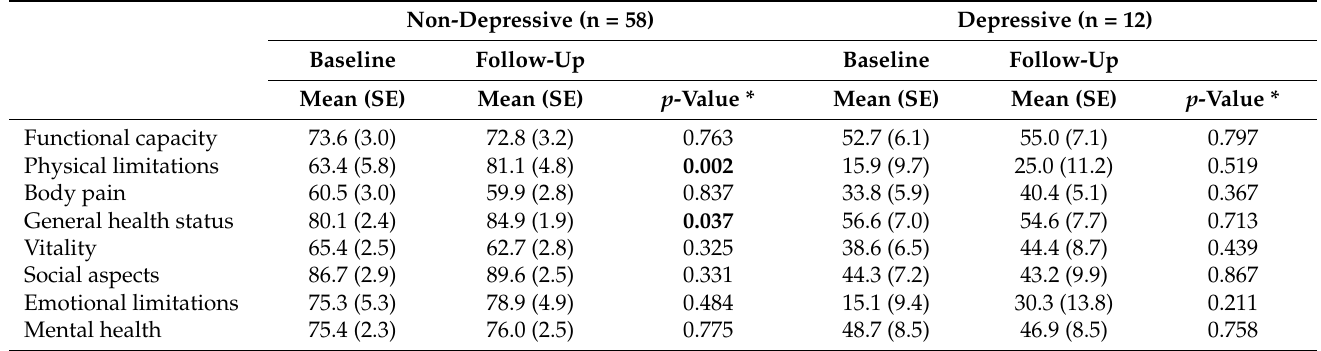
Table 2. Domain scores of quality of life at baseline and after a 12-month follow-up according to persistent depressive symptoms in breast cancer survivors (n =